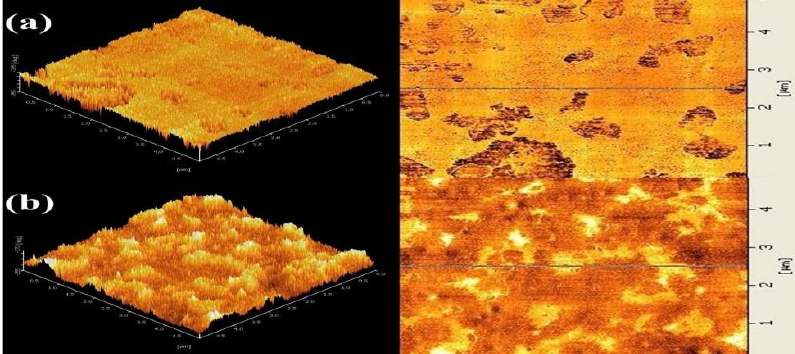
Figure 9. Phase image. ( a ) Neat binder; ( b ) CR modified binder. Reprinted with permission from [102]. Copyright © 2022 Elsevier Ltd.